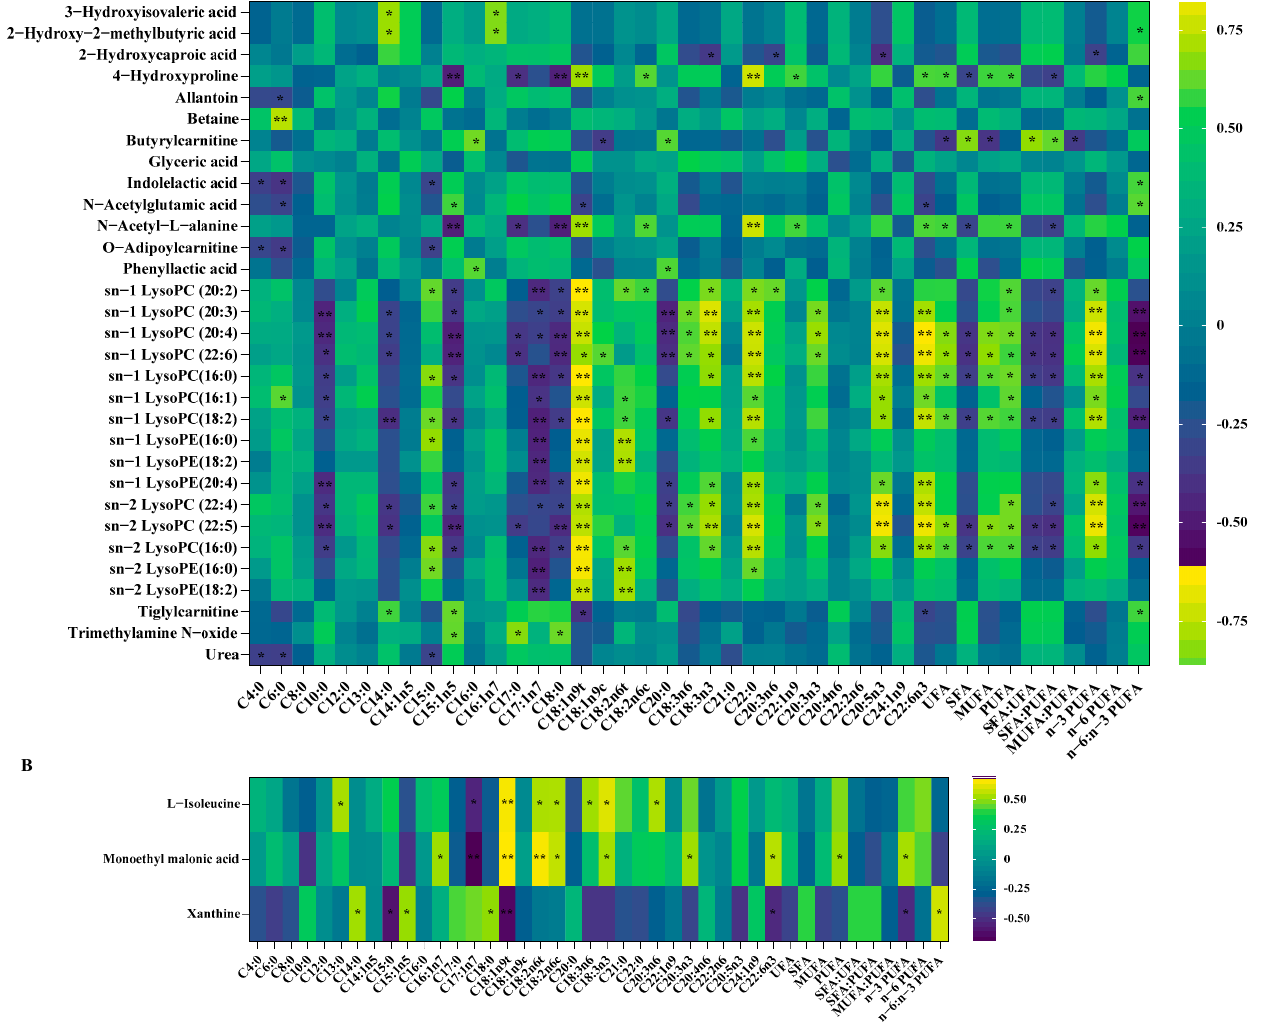
lambs treated with either control or mannan oligosaccharides milk replacer. Lambs were fed milk replacers with or without 0.2% mannan oligosaccharides (MOS; n = 15 per treatment in growth performance measurement; n = 12 per treatment in metabolome analyses). The growth performances in 30 lambs and the serum and urine metabolites in 24 lambs divided into two groups based on MOS supplementation are shown for the 3–week collection phase of the study. ADG: Average daily weight gain; DMD: Dry matter apparent digestibility; OMD: Organic matter apparent digestibility; CPD: Crude protein apparent digestibility; EED: Ether extract apparent digestibility; CaD: Calcium apparent digestibility; PD: Phosphorus apparent digestibility. * Values within cells differ significantly at p ≤ 0.05, and ** values within cells differ significantly at p ≤ 0.01.